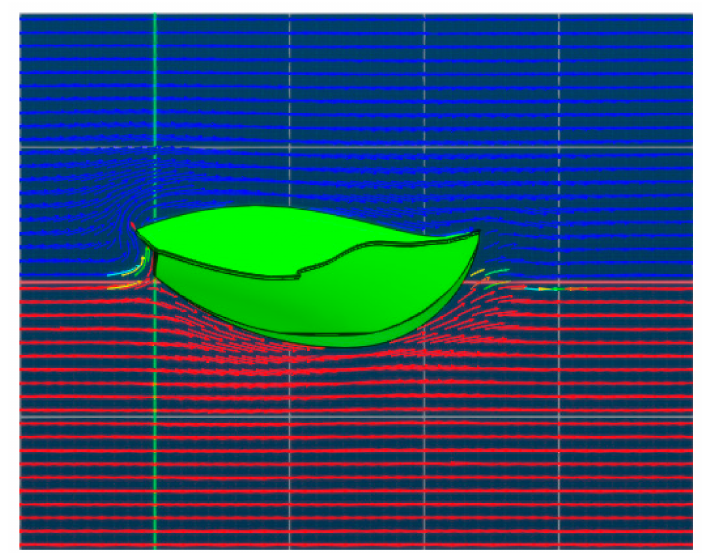
Figure 20. CFD Multiphase Flow